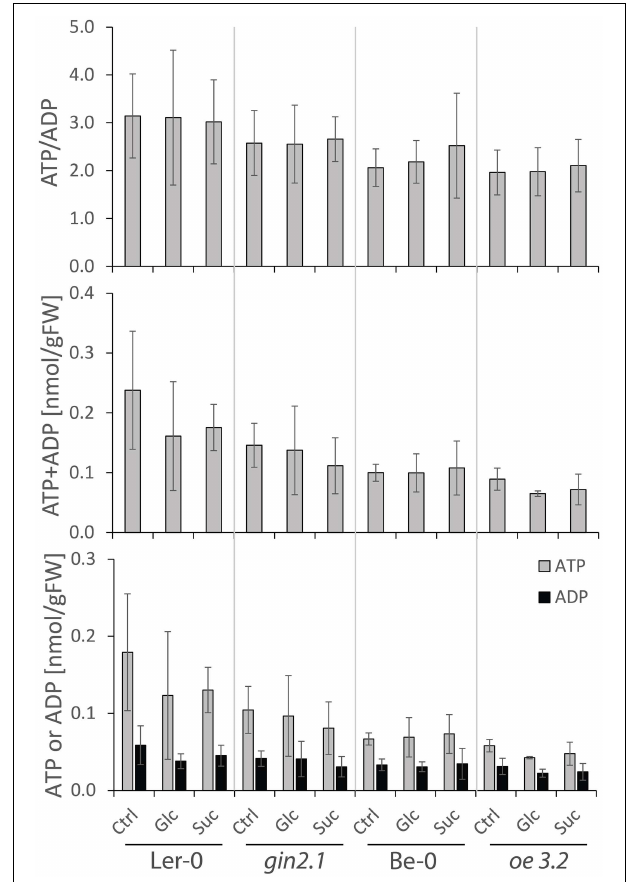
FIGURE 7 | Effects of short (1h) exposure to external Glc or Suc on ATP and ADP contents in shoots of A. thaliana wt plants and HXK1 -transgenics ( gin2.1 mutant and oe3.2 overexpressor). The A. thaliana seedlings were grown for 7 days in liquid media under a 16h light/ 8h dark photoperiod, followed by a 24h treatment. Subsequently, the seedlings were dipped for 1h either into water, 1% Glc or 1% Suc, and the samples were collected for adenylate content analyses. Data are shown as average ± sd. Significance: t